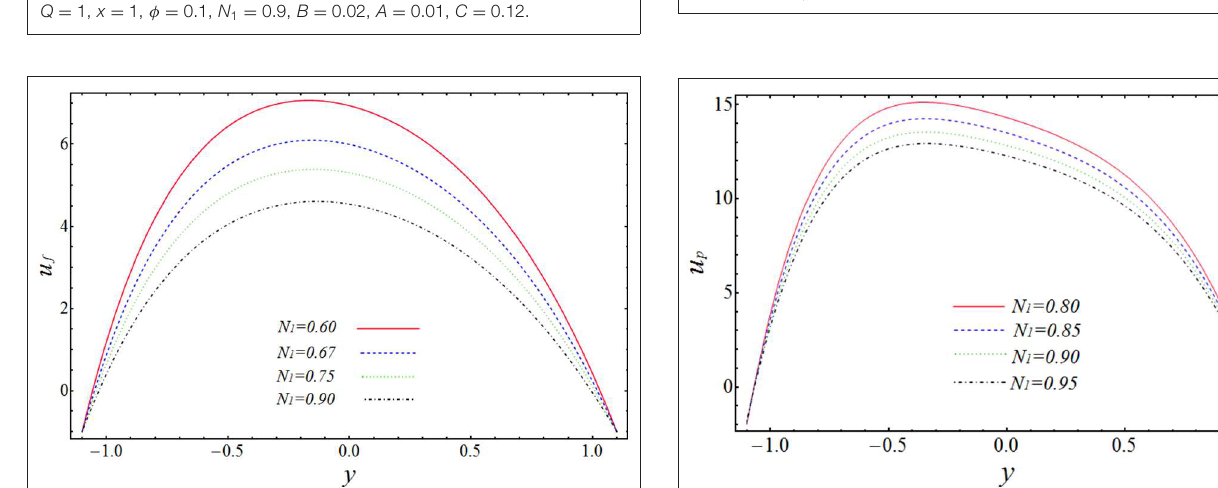
FIGURE 4 | Change of velocity u p for k 1 when Q = 1, x = 1, φ = 0.1, N 1 = 2, B = 0.02, A = 0.05, C = 0.01.